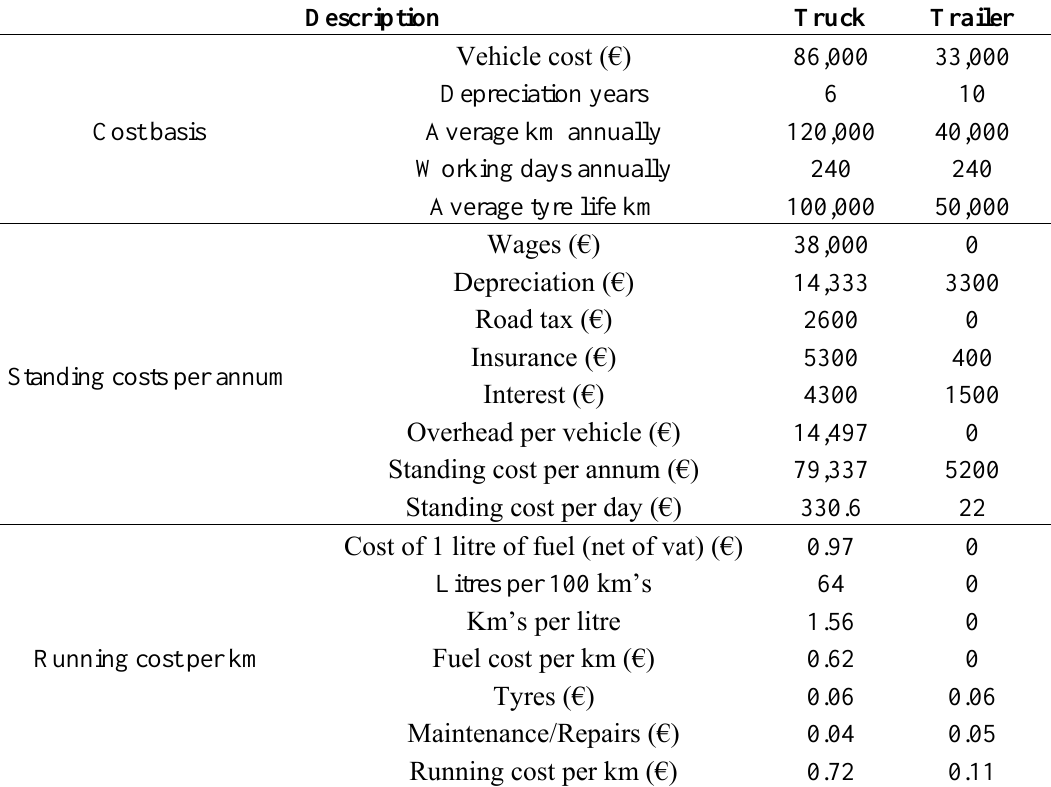
Table 6. Truck and trailer standing and running costs for six axle articulated truck